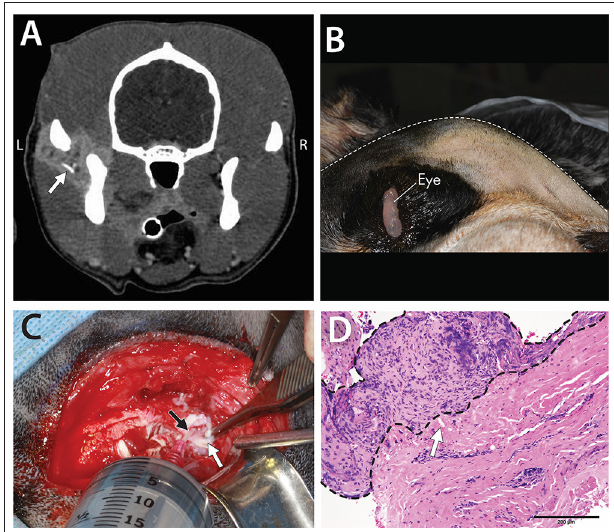
FIGURE 2 | A 5-year-old dog affected by septic arthritis of the left TMJ described in Case 1. (A) Contrast-enhanced CT demonstrated inflamed soft tissues as well as a foreign body (arrow) surrounding the TMJ. (B) Image obtained with the dog in the right lateral recumbency. Note the substantial swelling on the left side of the face. (C) The exposed lateral aspect of the left TMJ with the disc (white arrow) retracted ventrally to allow the 18G catheter (black arrow) to enter the dorsal compartment of the joint for irrigation. (D) Histopathological findings demonstrated chronic suppurative inflammation with profound hyperplasia of the joint synovium and extensive fibrosis. Also noted is a foreign body embedded in the tissues (white arrow) [H&E staining and Bar = 200 µ